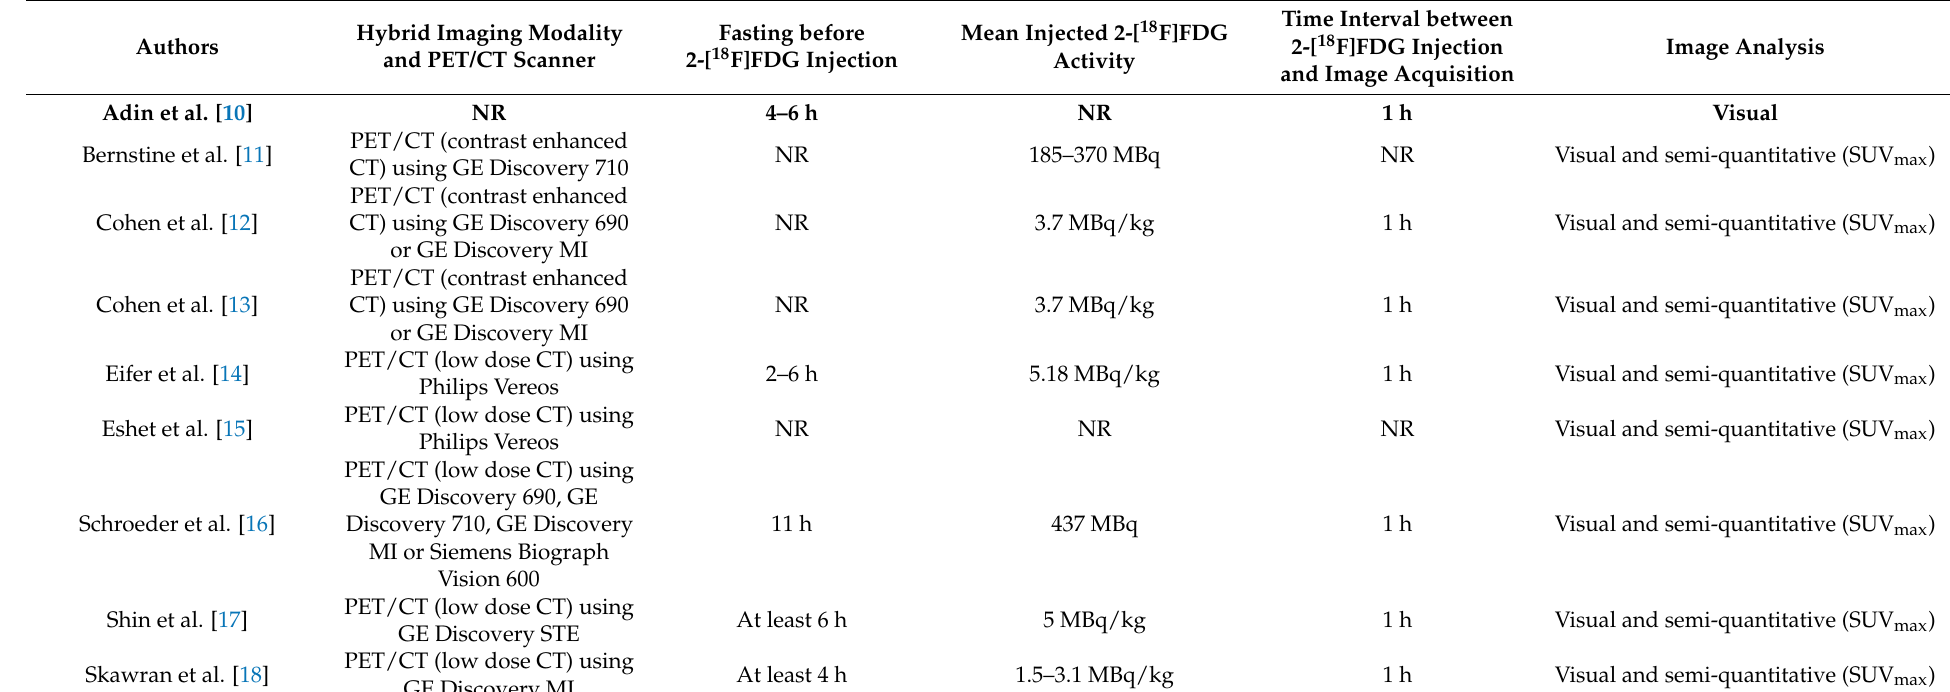
Table 2. Technical aspects of 2-[ 18 F]FDG PET/CT in the included